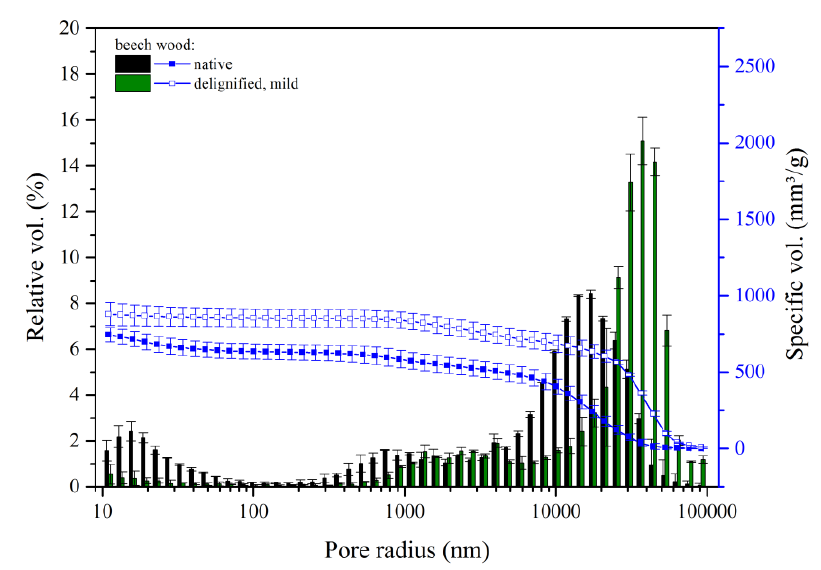
Figure 3. Porosity of native versus mild delignified wood, both oven dried after delignification. Cumulative pore volume and histogram of relative pore volume as a function of the pore radius of native and delignified beech wood following the mild delignification method (60 °C, 8 h). For delignification at high temperature (DD ≈ 35%), the reduction of the volume of small pores than 30 µ m was increasing. Again, this effect was more prominent for the harsh delignification method.